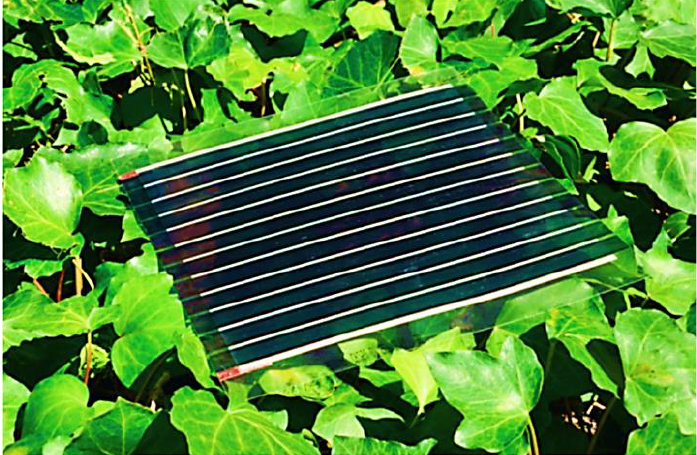
Figure 7. A green polymer/fullerene solar cell [82]. Reproduced with permission from ACS.